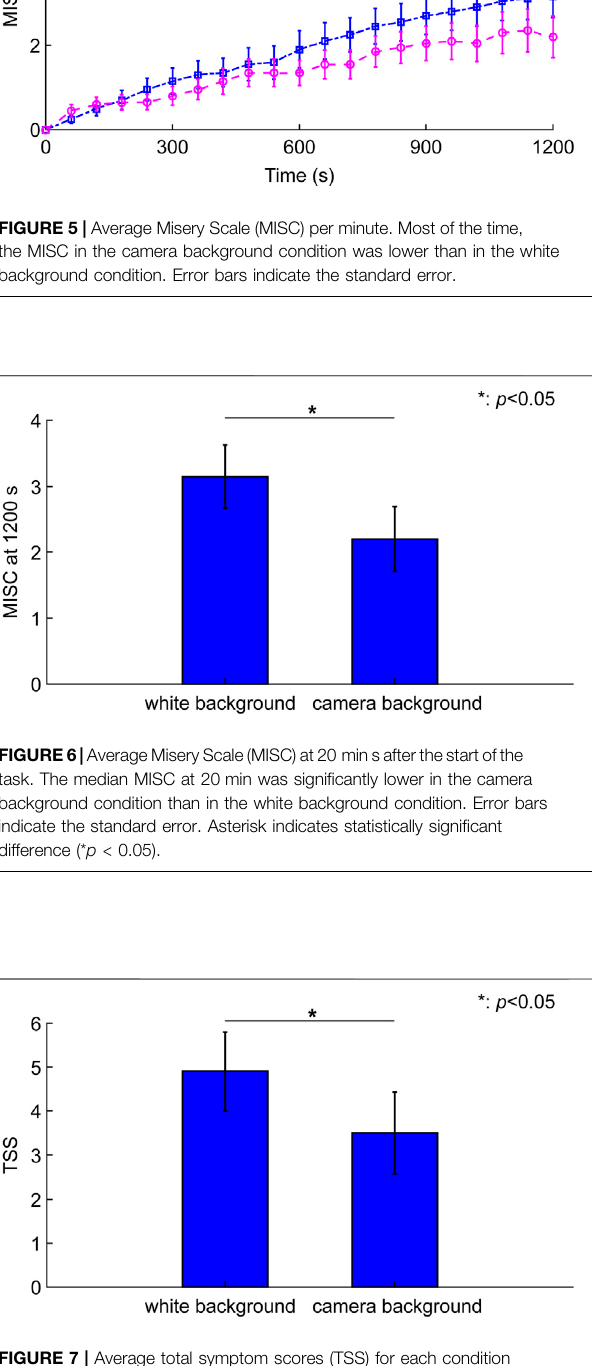
FIGURE 7 | Average total symptom scores (TSS) for each condition immediately after the task was completed. The median TSS was signi fi cantly lower in the camera background condition than in the white background condition. Error bars indicate the standard error. Asterisk indicates statistically signi fi cant difference (* p <